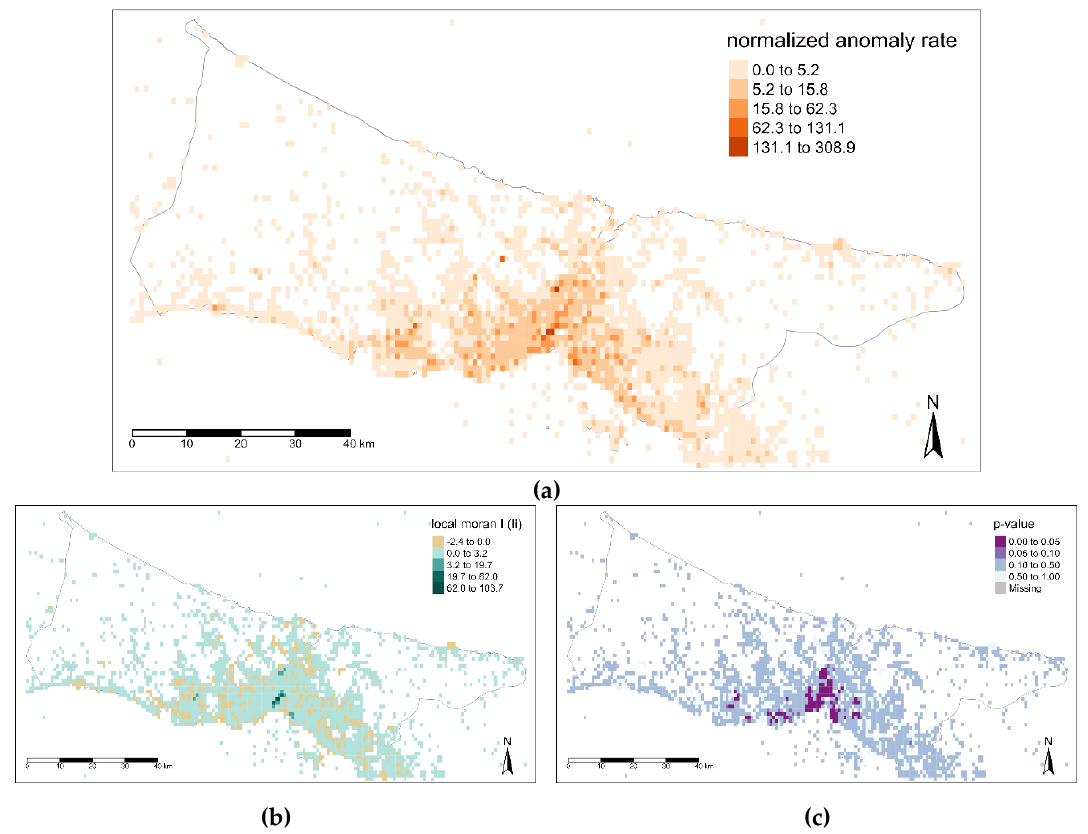
Figure 12. Anomaly tendency assessment ( a ) Overall anomaly rate; ( b ) local Moran’s I; ( c ) local Moran’s p -value.